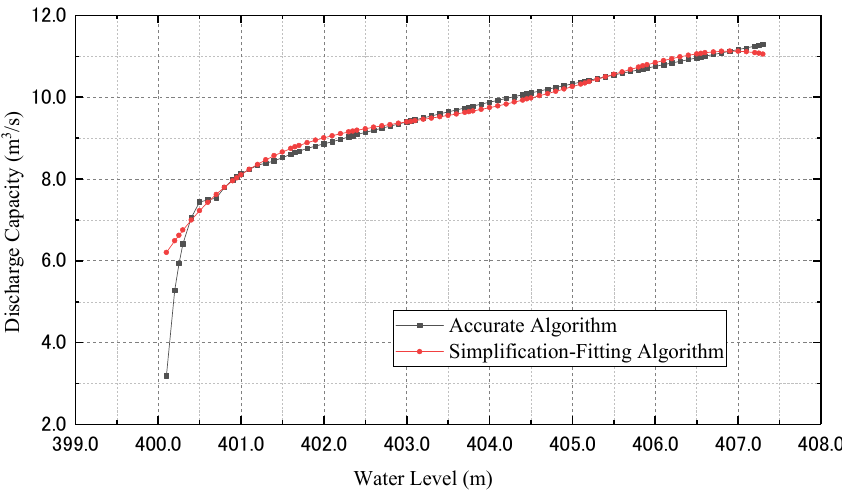
Figure 9. Figure on discharge capacity results from both simplified and accurate algorithms in the pressure flow stage.